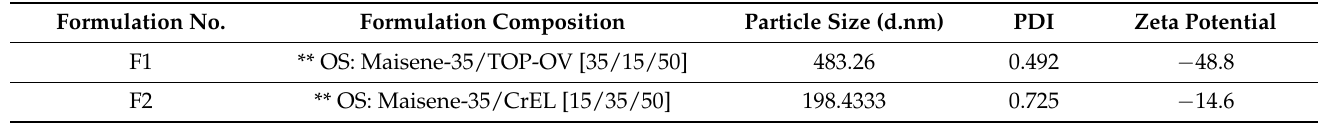
Table 2. Particle size and zeta potential measurement of the two SNEDDS formulations. Formulation No. Formulation